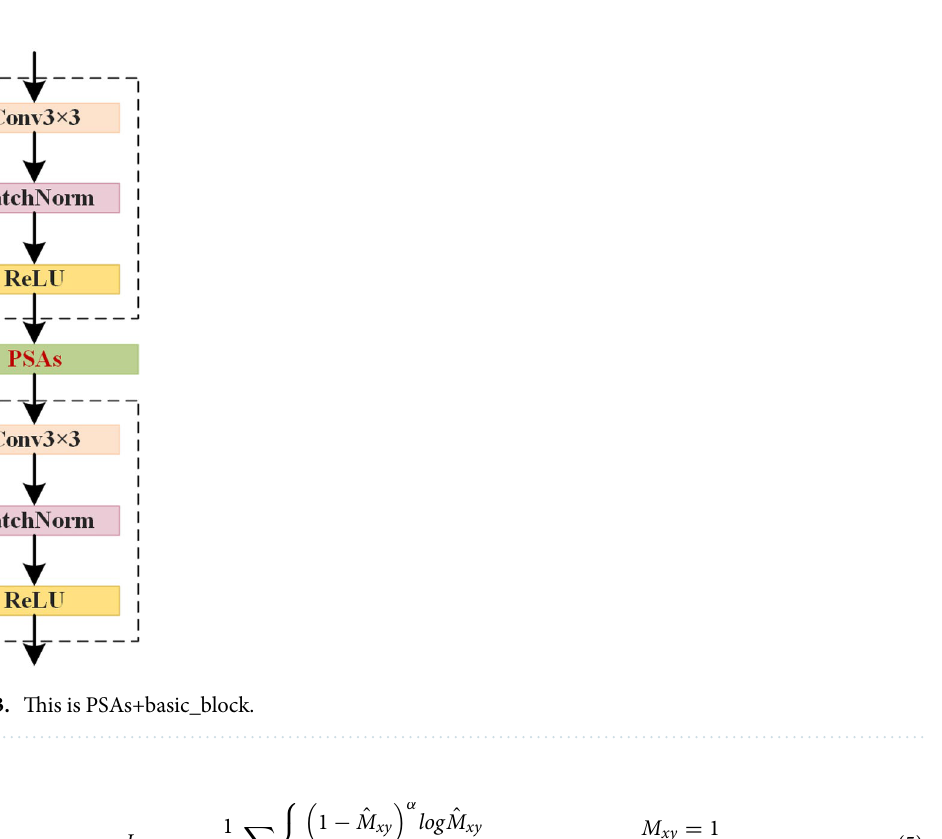
Table 1. Comparative experimental results on series/parallel fusion approaches of the PSA attention mechanism on the HRNet32 network.